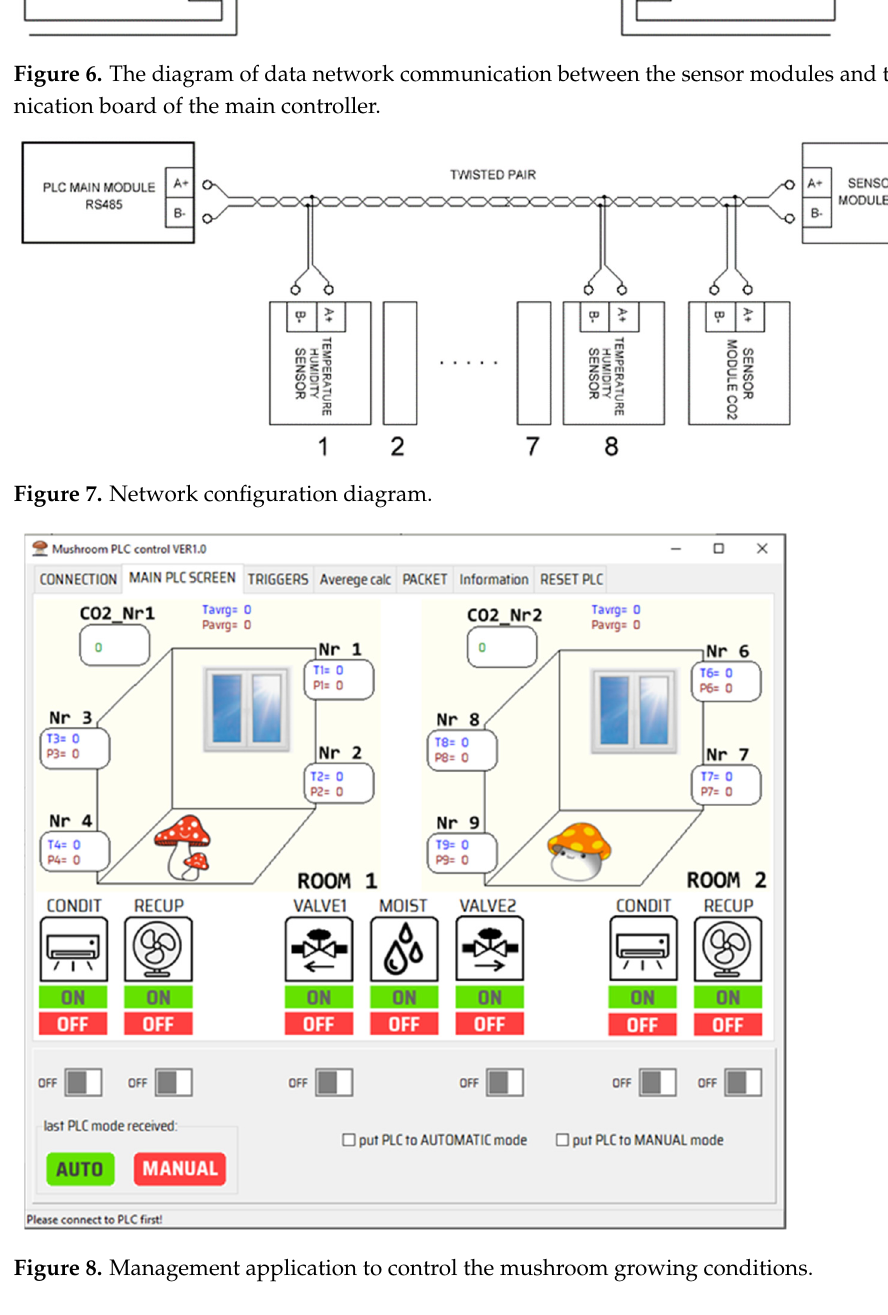
Figure 6. The diagram of data network communication between the sensor modules and the com- munication board of the main controller.